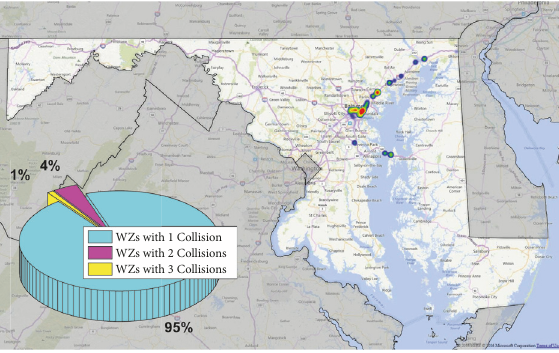
Figure 5: Heat map showing locations of 359 WZs within which 380 collisions occurred. The pie chart indicates that very few WZs had more than one